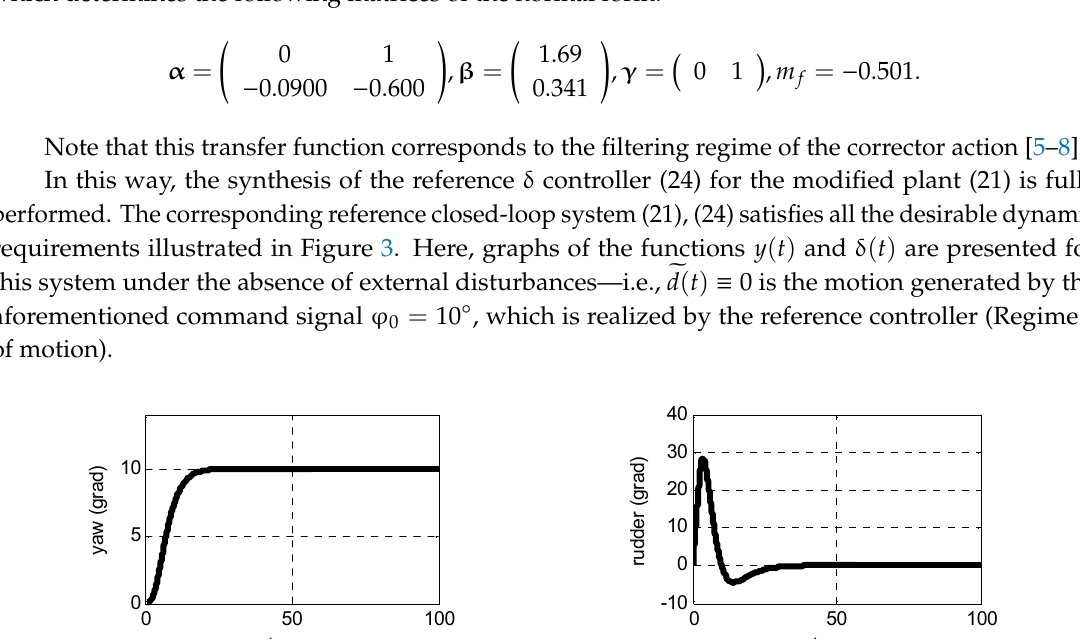
Figure 3. Graphs of the functions y ( t ) and δ ( t ) for the reference closed-loop connection in Regime 1 of motion.